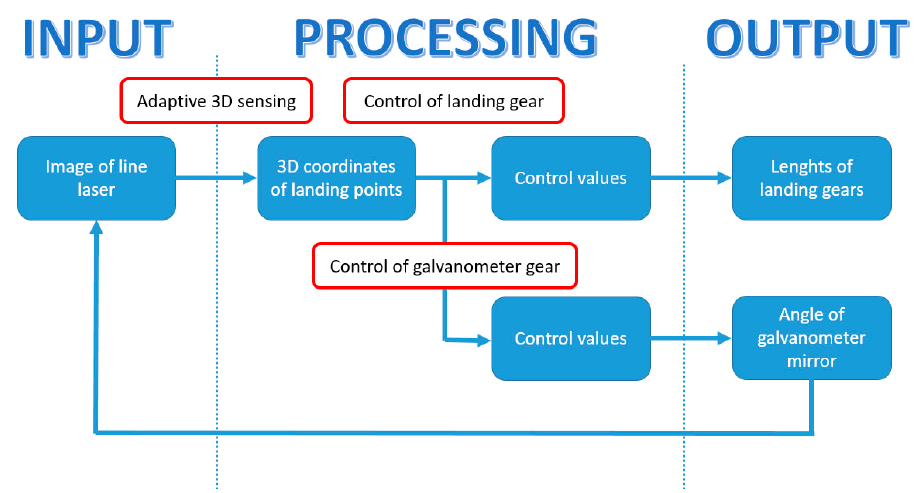
Figure 9. Flow diagram of the system proposed adapted from [82].